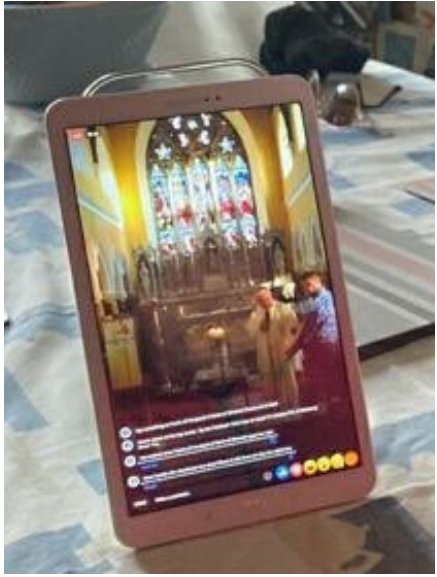
Figure 8. Interface of the church service via Facebook, coupled with comments and emoticons from fellow members of the congregation. Permission granted by Dr P. J. White, taken 2020.